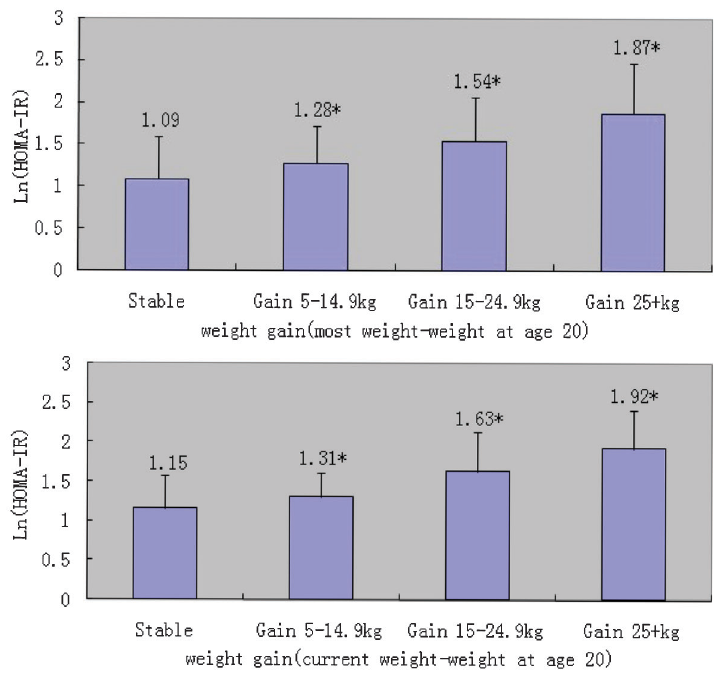
Figure 1. HOMA-IR by category of adult weight change among 844 residents in Wansong Community from October 2009 to April 2010. Adjusted for age, gender, and BMI at age 20. Stable weight change is gain or loss of less than 5 kg. HOMA-IR was log-transformed before analysis for it was not normally distributed. *P , 0.05 vs stable group (unpaired Student t -